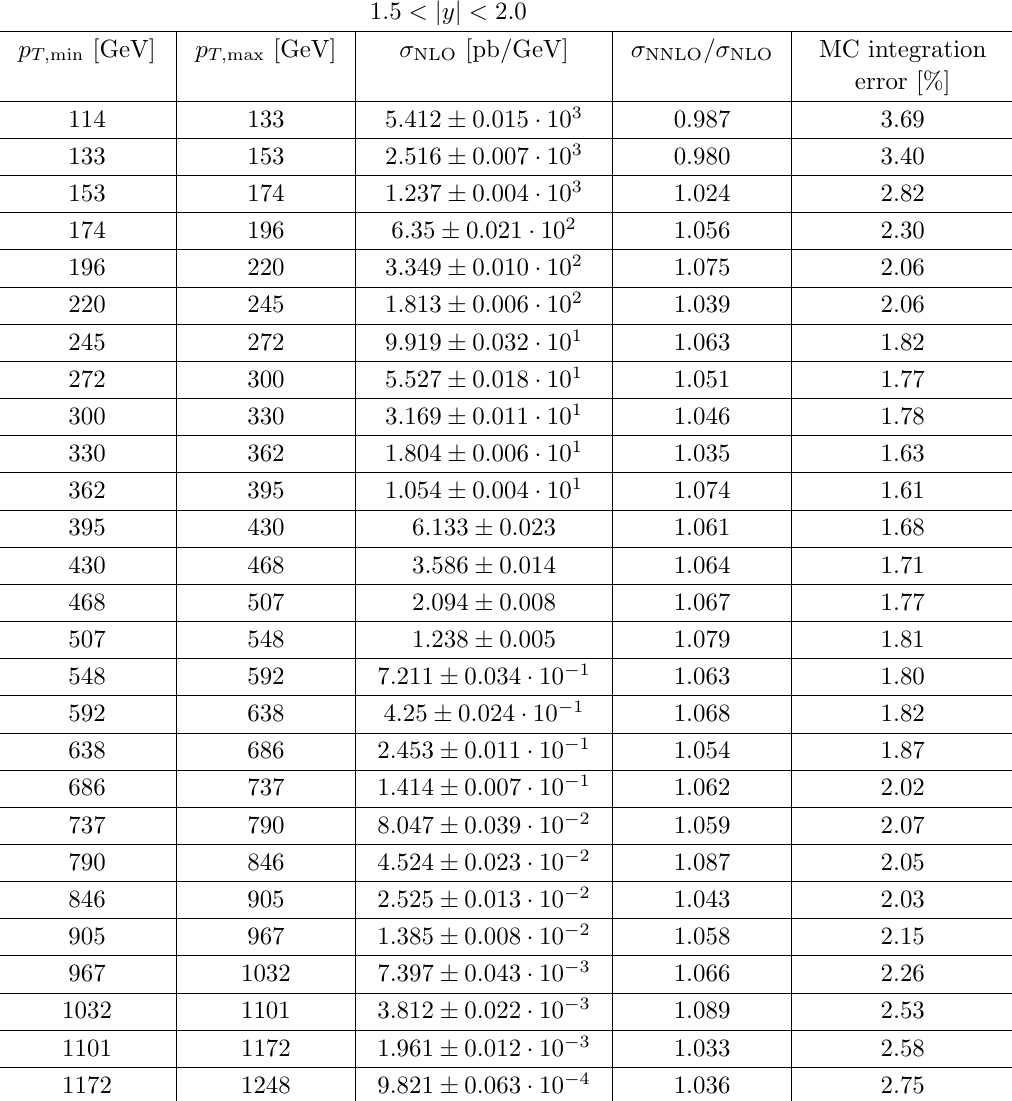
Table 4 . NLO QCD single-inclusive cross section and NNLO QCD K-factors in the rapidity slice y < 2 : 1 : 5 < j j